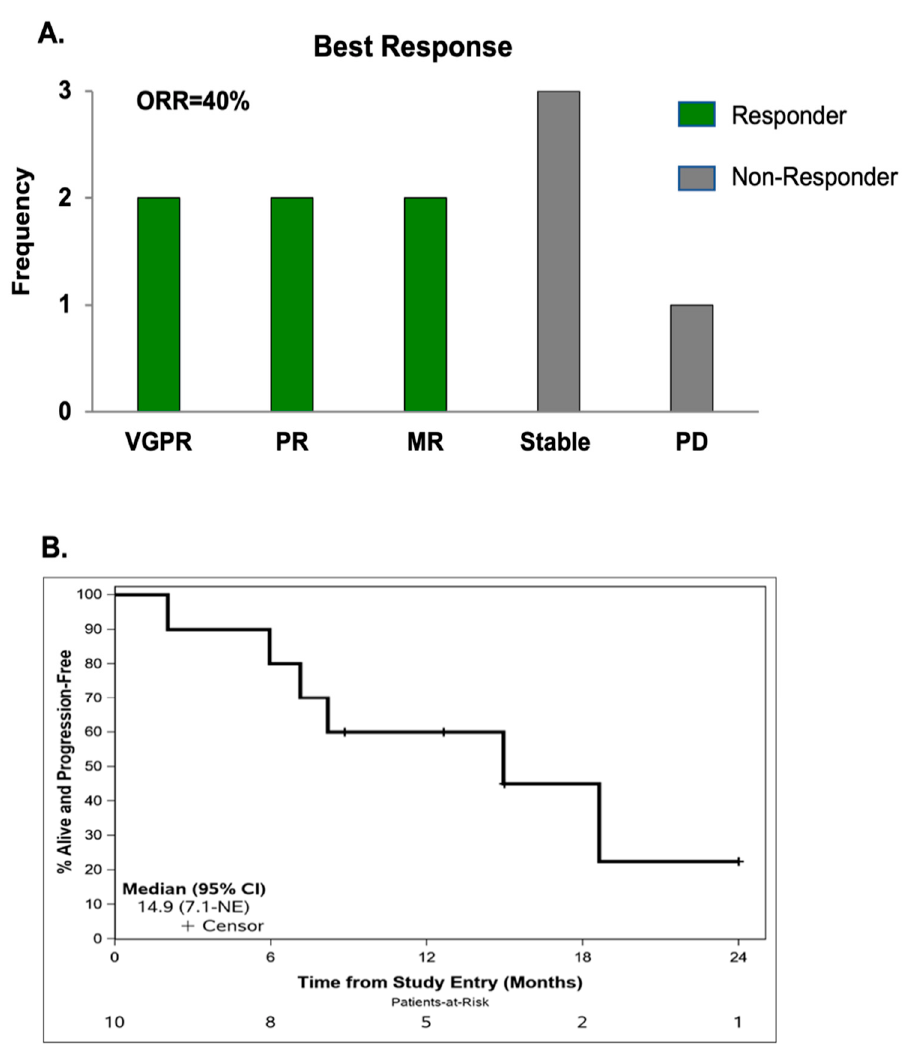
Figure 3. Clinical response and progression free survival (PFS) in MM patients treated with the ARd regimen. ( A ) Overall response rate (ORR) was assessed in 10 patients treated with ARd and was 40% (2 VGPR, 2 PR, 2 MR, 3 SD, 1 PD). ( B ) The median PFS for all patients was 14.9 months (95% CI 7.1-NR).